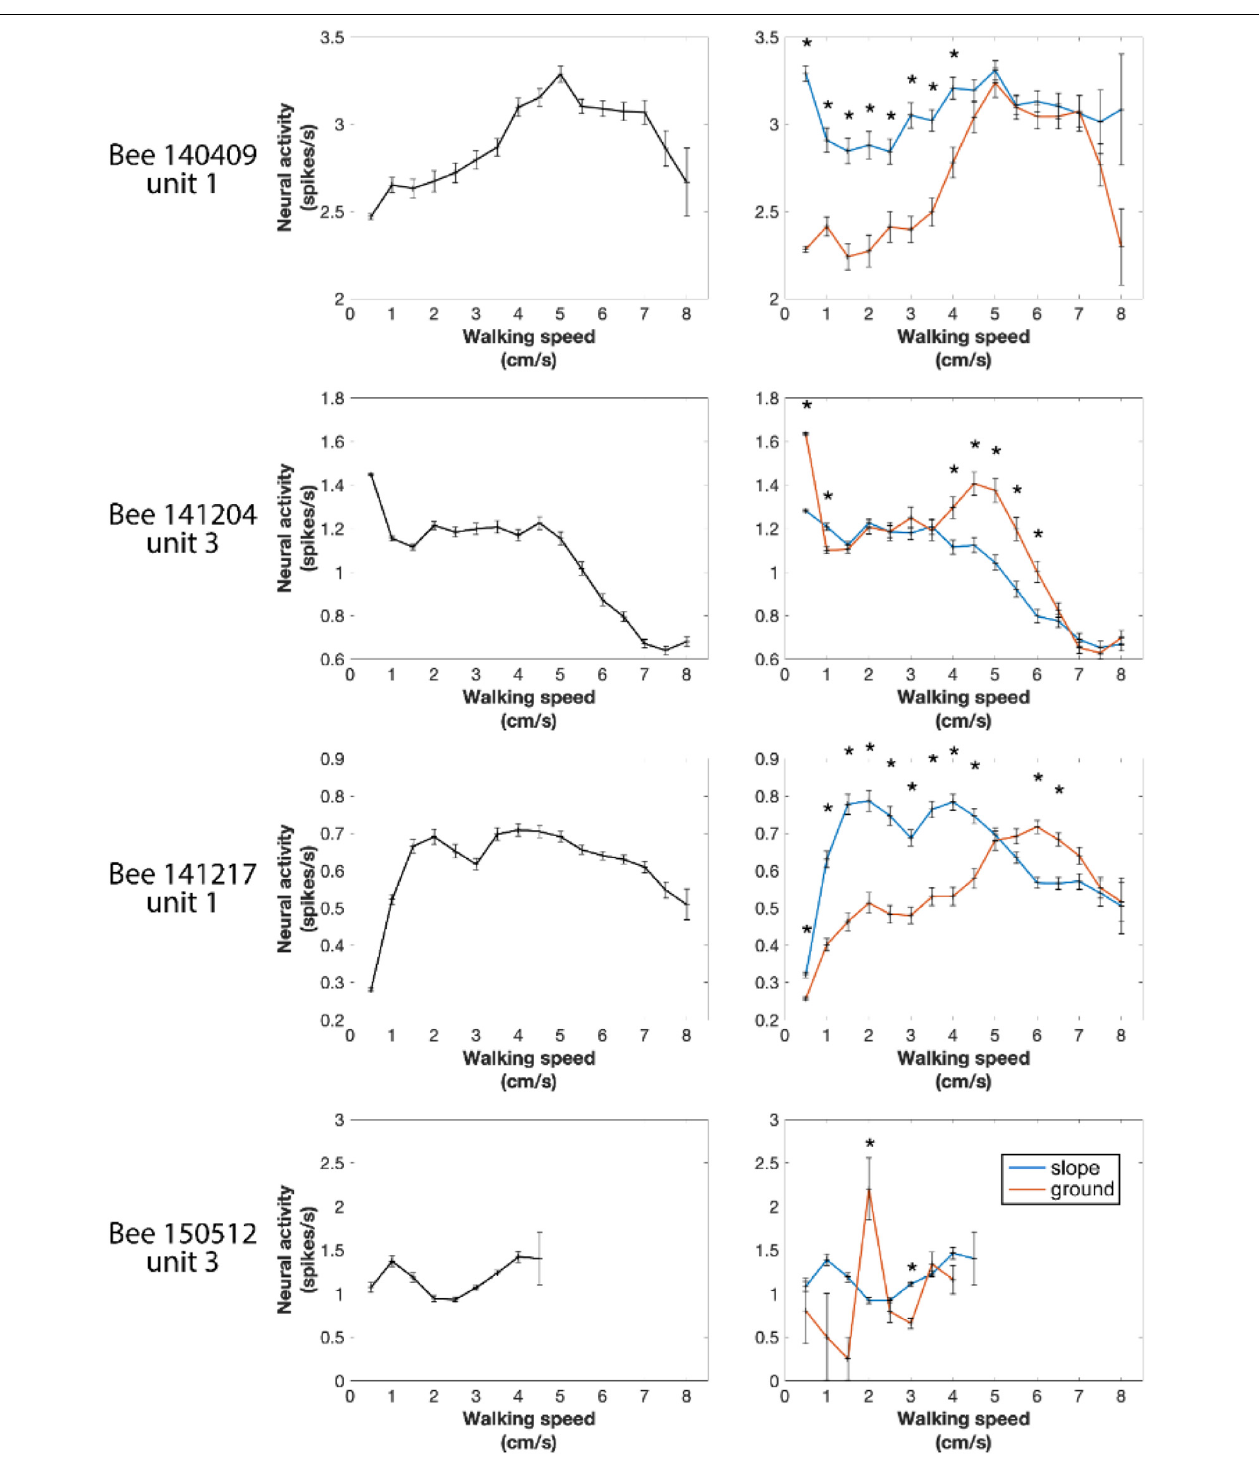
FIGURE 7 | Four examples of neural activity at different walking speeds in the entire arena and in the two different compartments of the arena (ground and slope). Spike numbers were pooled by every speed segment of 0.5 cm/s from 0 to 8 cm/s and in each speed group normalized to 1 s. Left panels: entire arena. One-way ANOVA showed statistically significant difference in every recorded neuronal unit (all p values < 0.001), indicating that in each neuron at least two speeds were correlated with different neural activity. Right panels: neural activity separately calculated for different walking speeds on the slope and the ground. Units were differently active when the bee walked on the two compartments of the arena at some speeds but not all. * p < 0.05 in Wilcoxon rank sum tests with Bonferroni correction.